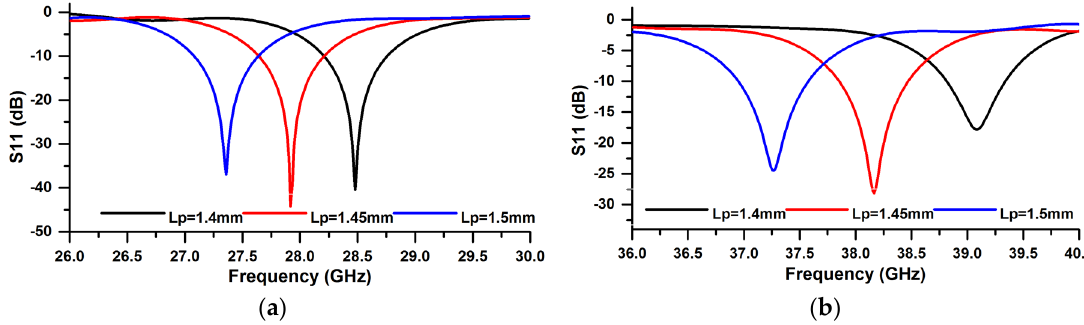
Figure 2. The reflection coe ffi cient with variation of Lp: ( a ) at 28 GHz band and ( b ) at 38 GHz band. Figure 2. The reflection coefficient with variation of Lp: ( a ) at 28 GHz band and ( b ) at 38 GHz band. Figure 2. The reflection coefficient with variation of Lp: ( a ) at 28 GHz band and ( b ) at 38 GHz band. Figure 2. The reflection coefficient with variation of Lp: ( a ) at 28 GHz band and ( b ) at 38 GHz band.